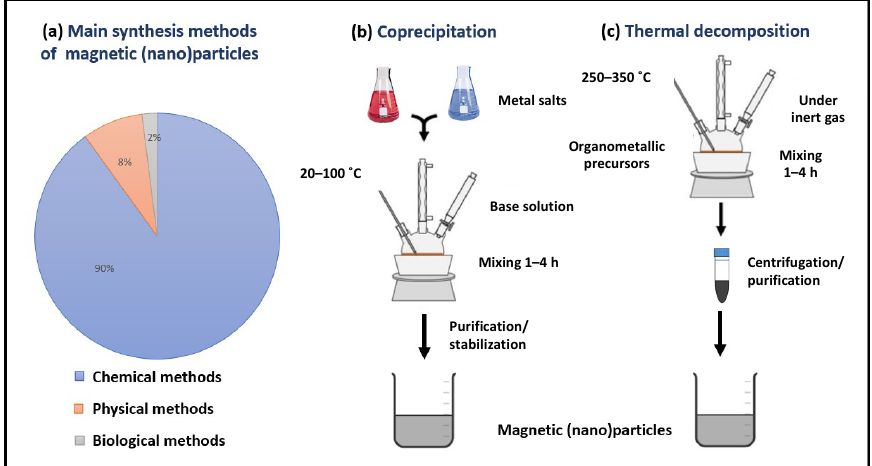
Figure 1. ( a ) Scheme depicting the main routes to synthesize magnetic (nano)particles. Diagrams for the preparation of magnetic (nano)particles employing ( b ) coprecipitation and ( c ) thermal decomposition approaches [22] .